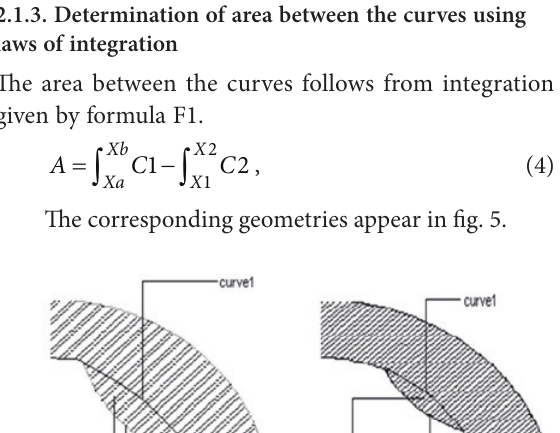
Fig. 4. Intersection points (X1&X2) in rose petal and star grain configuration